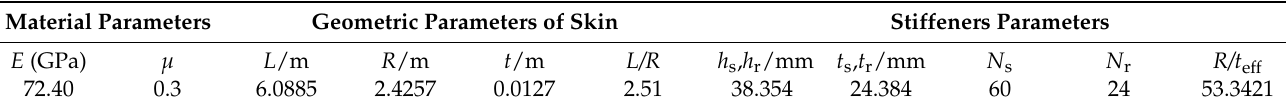
Table 8. Geometric and material parameters of the LRRSC.